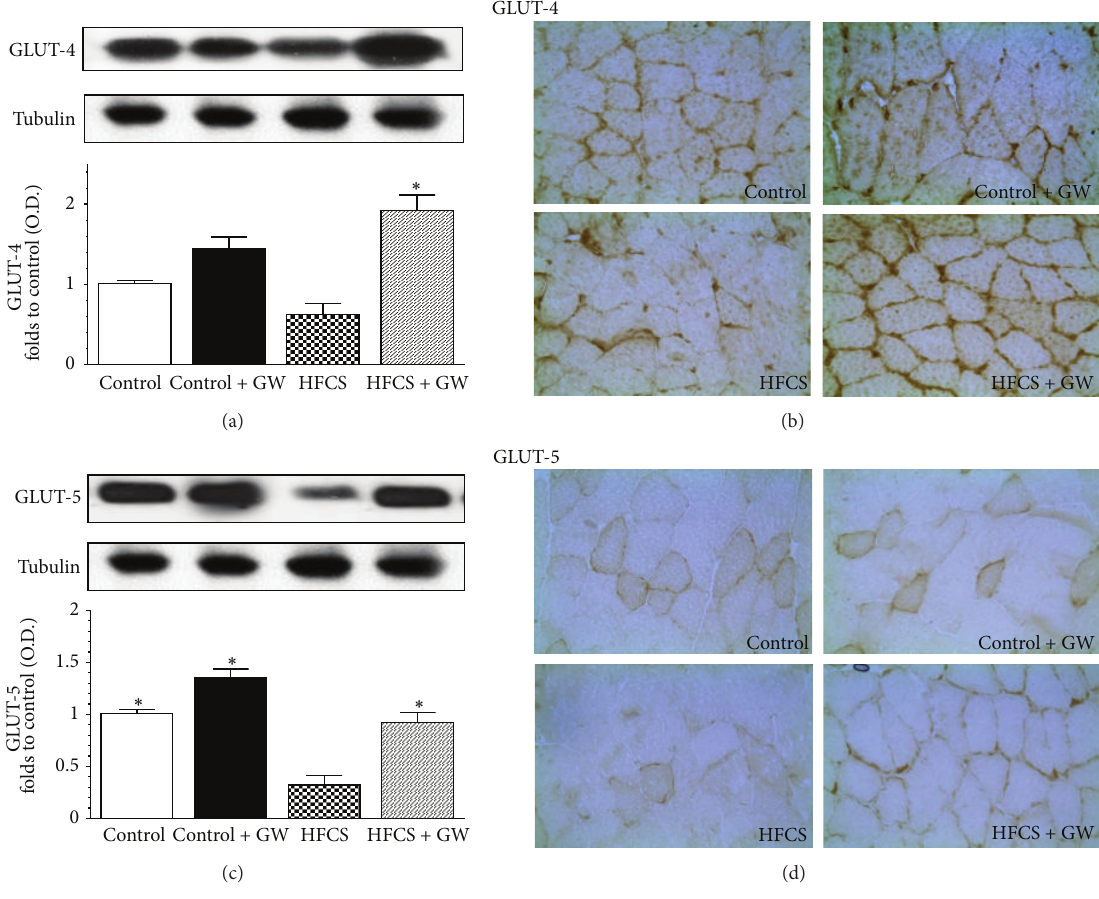
Figure 3: Effects of two dietary regimens either normal (control) or a diet enriched with 15% HFCS solution (HFCS) on GLUT-4 and GLUT-5 expression (resp., (a) and (c)) and membrane translocation (resp., (b) and (d), original magnification: 400x) in the gastrocnemius of mice treated with GW0742 (1mg/kg/day, control + GW; HFCS + GW). Densitometric analysis of the bands is expressed as relative optical density (O.D.), corrected for the corresponding tubulin, and normalized using the related control band. Data are means ± SD of three separate experiments. ∗ 𝑃 < 0.01 versus